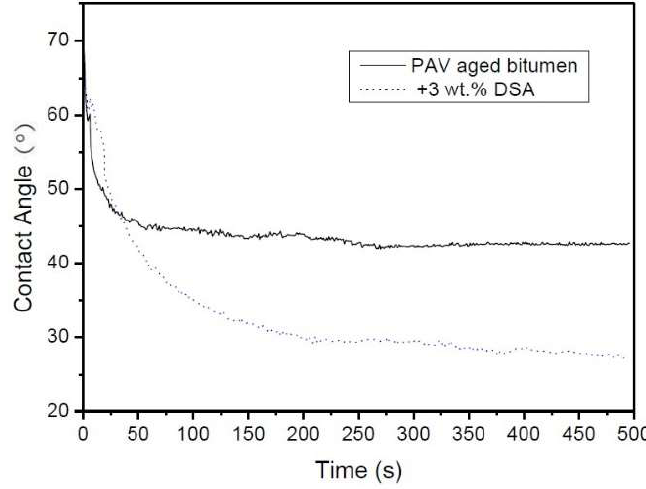
Figure 13. Evolution of contact angle with time during the spreading test, at 110 °C, for a PAV aged bitumen before and after DSA modification.